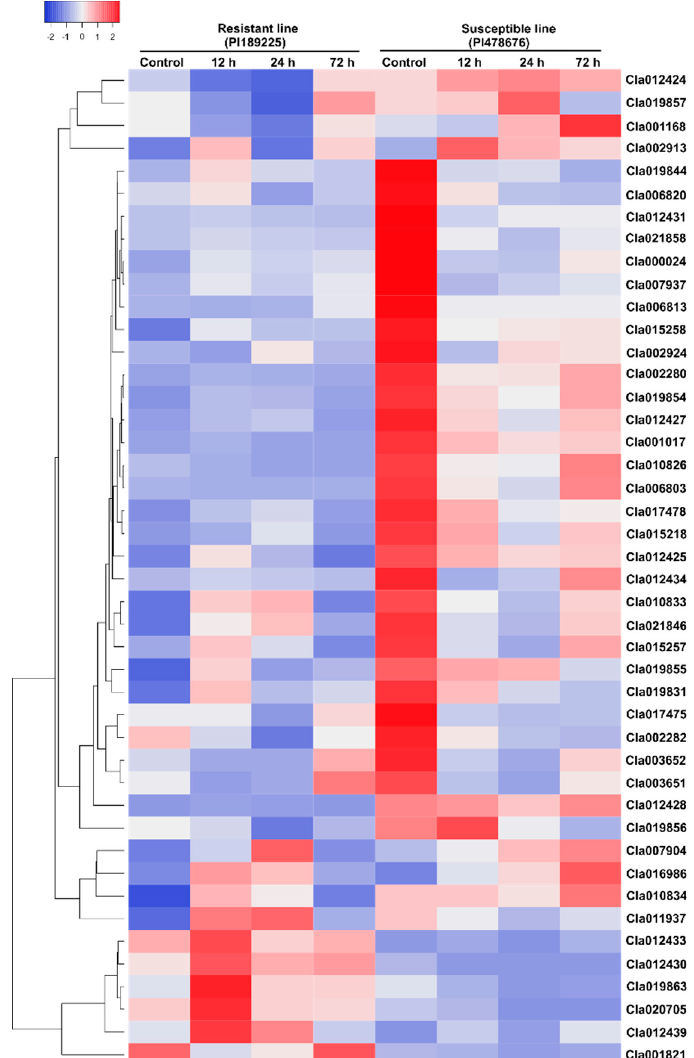
Figure 6. Heat map of the expression patterns of the 44 NBS-encoding R genes determined by qRT-PCR in gummy stem blight resistant and susceptible watermelon lines subjected to Didymella bryoniae infection at various time points. The expression levels were normalized with the Actin gene. The values were obtained from the means of three technical replicates. Red and blue represent the maximum and minimum values, respectively. The heat map was generated with an online tool ‘Heatmapper’ (http://www.heatmapper.ca/expression/).